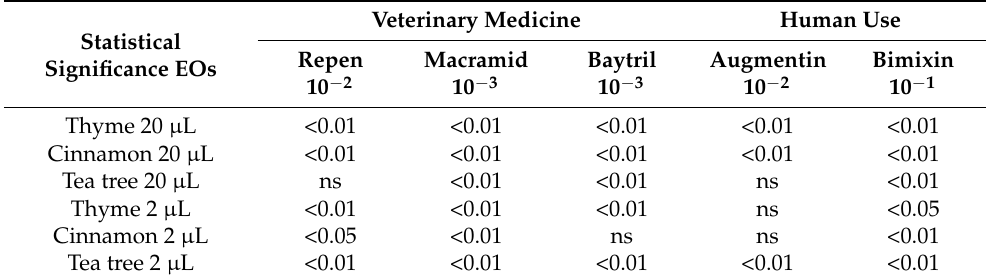
Table 7. Statistical significance among aromatograms of three EOs (thyme, cinnamon, tea tree) at two volumes (20 µ L and 2 µ L) vs. antibiotics for veterinarian and human use, respectively. Data interpretation in Section